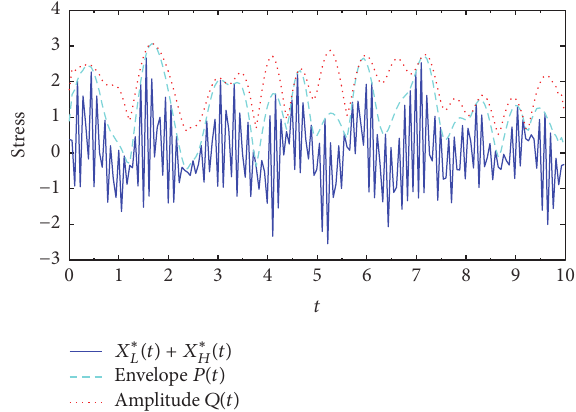
Figure 1: Bimodal process 𝑋 ∗ (𝑡) , the envelope process 𝑃(𝑡) , and the amplitude process 𝑄(𝑡)